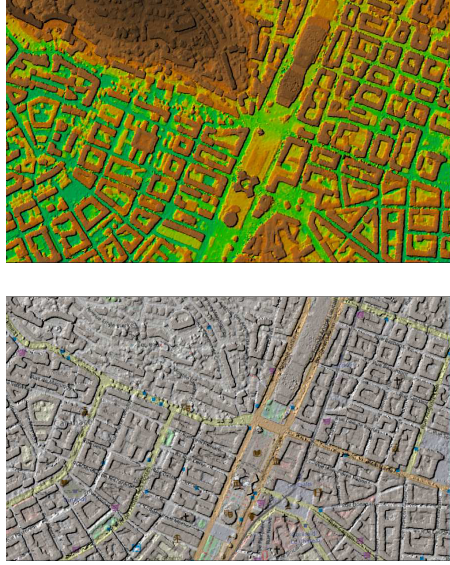
Figure 8: DSM of Nice-Acropolis Congress (raw and mapped on Open Streep Map) generated in unit tests